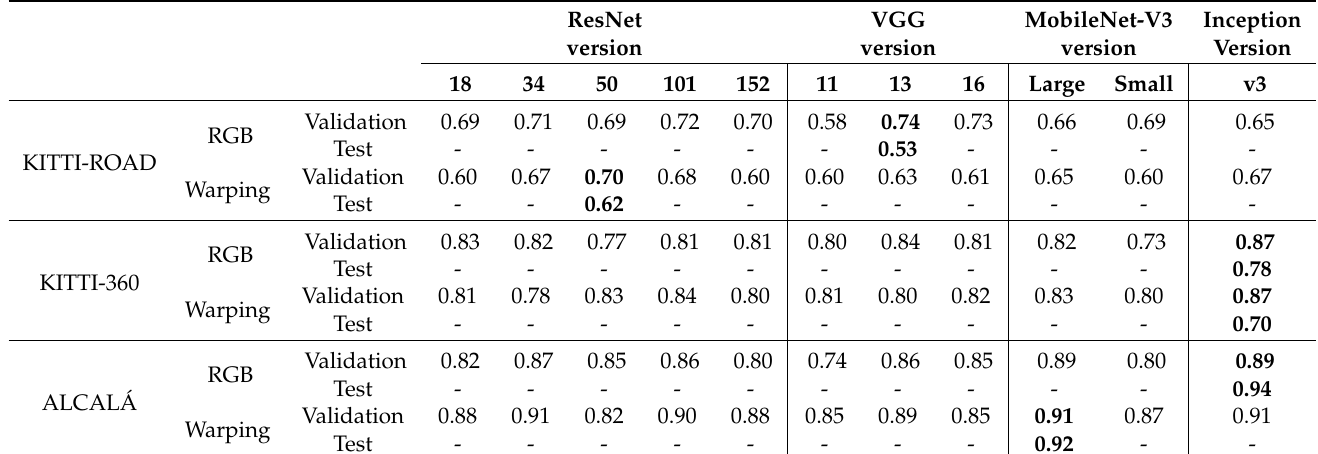
Table 3. Baseline